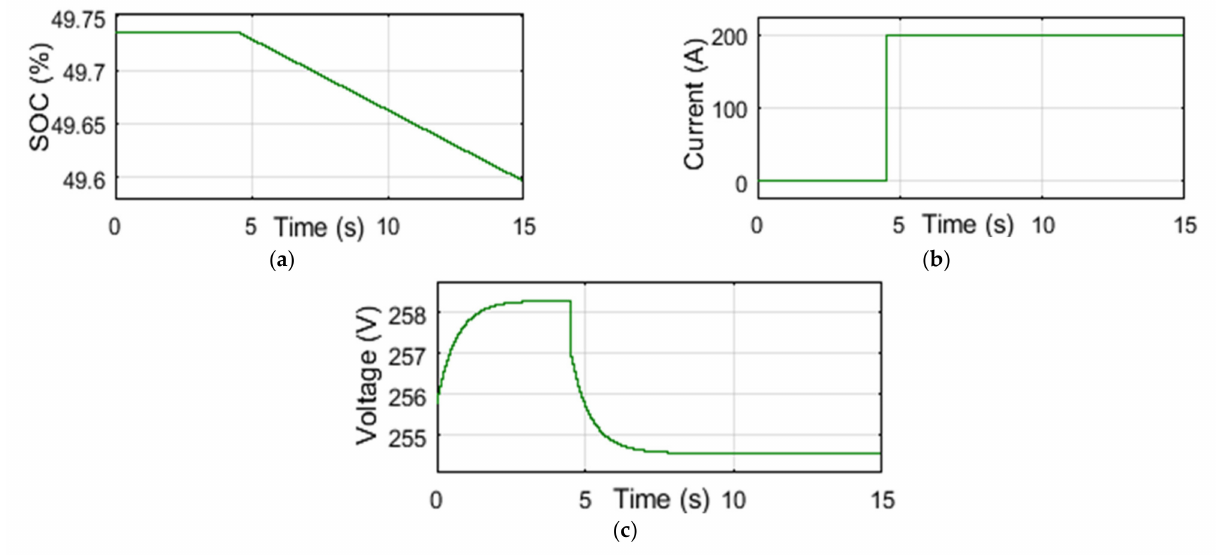
Figure 16. ( a ) The BESS SOC condition, ( b ) BESS current condition and, ( c ) BESS voltage condition, where the BESS is